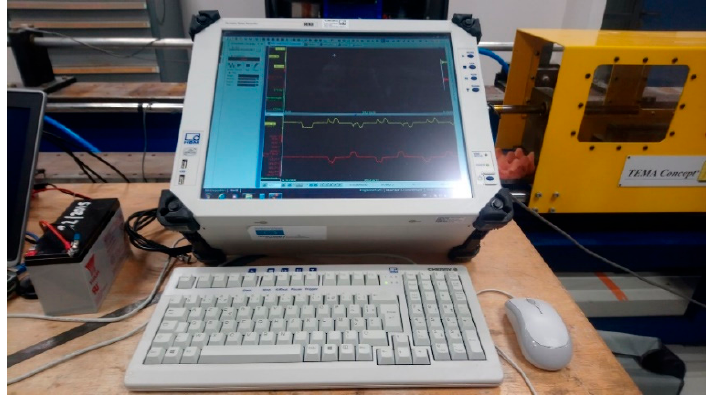
Figure 5. Split Hopkinson Pressure Bar.